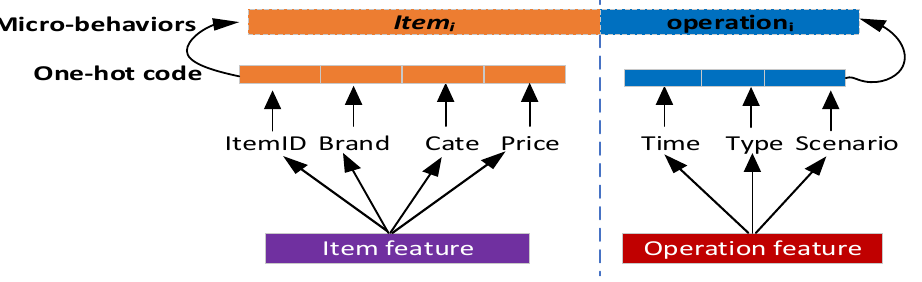
Figure 2. User micro-behavior flow chart.